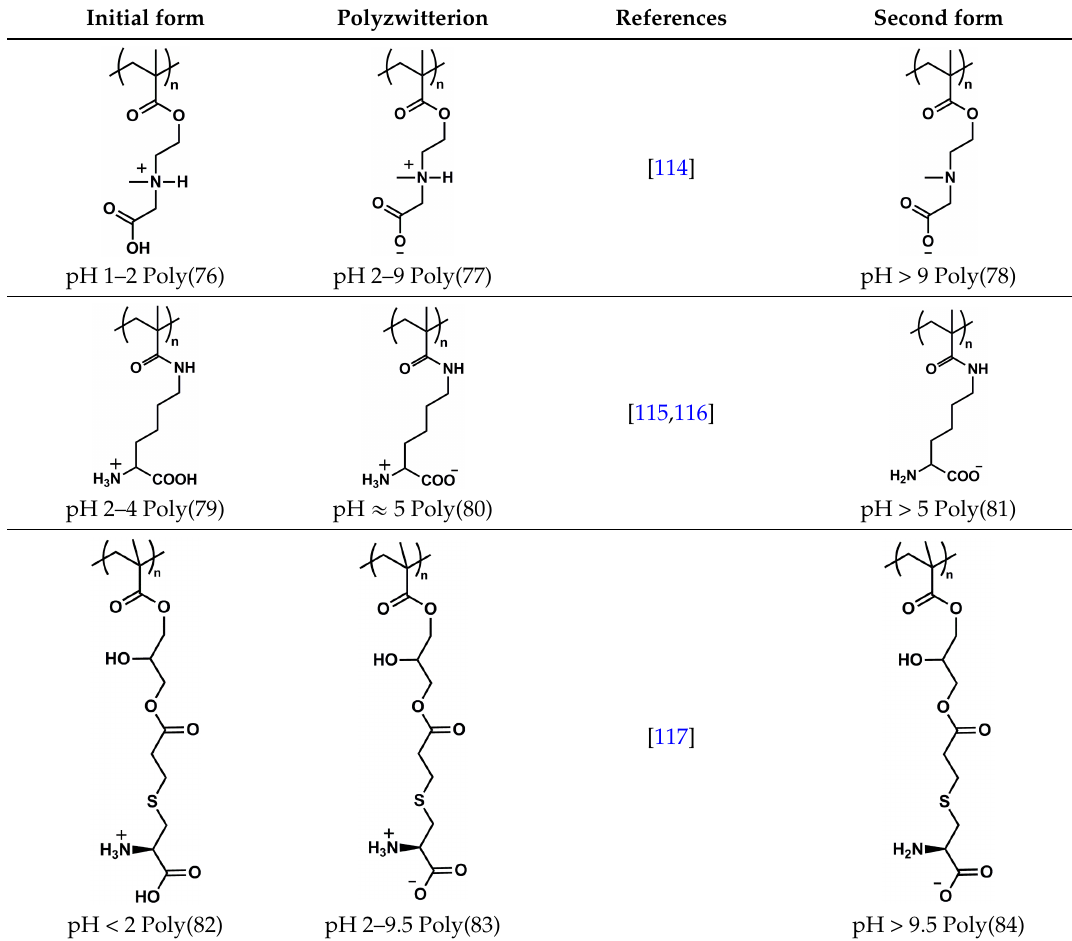
Table 7. Reversible double switch.